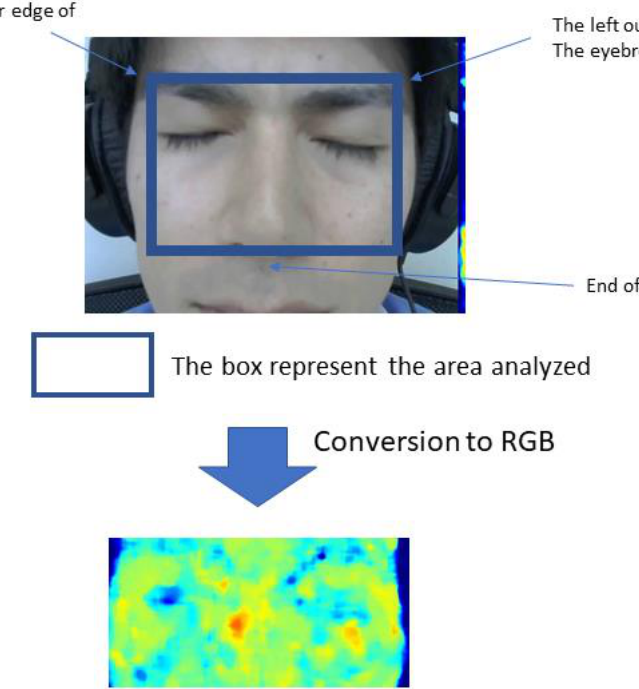
Figure 2. Representative facial image. The region of interest is defined by the outer edge of the eyebrows and the base of the nose. The obtained signal was converted to red, green, and blue values (8-bit color depth) contained in each pixel in the designated area of all image frames. This subject consented to the use of these images.